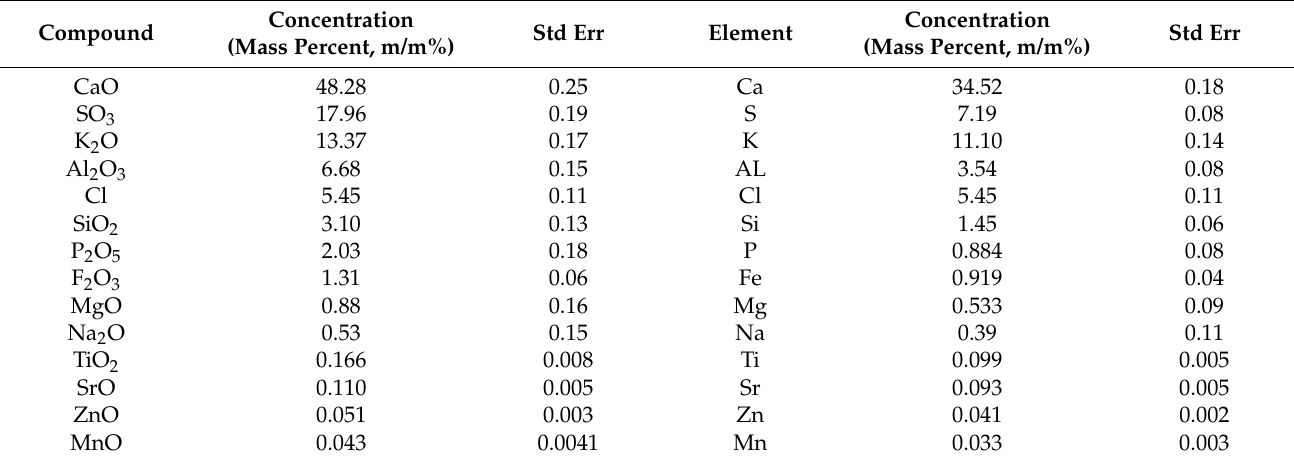
Mineral composition of Fagonia indica (areal parts) using energy dispersive X-ray fluorescence